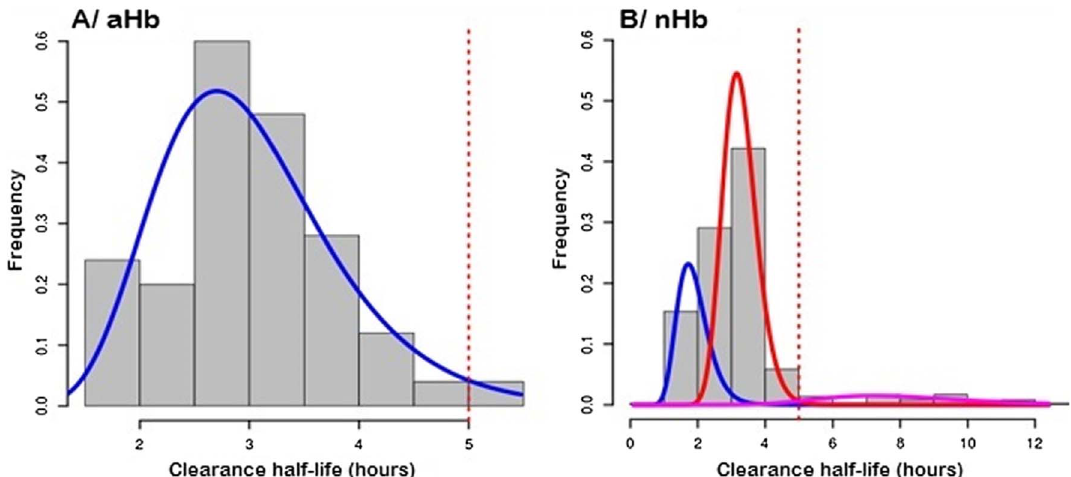
Figure 2. Modeling the population parasite number according to the hemoglobin type. The parasite half-life time is plotted for those with (A) or without (B) abnormal hemoglobin according to the White et al. [27] , distribution model. For aHb, the model describes only one phenotype (half-life time = 2.15 ± 1.37 h), whereas for nHb, three phenotypes were found: i) phenotype 1 (blue line, half-life time = 1.83 ± 1.28 h) accounting for 25.4% of the patients, ii) phenotype 2 (red line, half-life time = 3.23 ± 1.17 h) accounting for 66.88% of the patients, and iii) phenotype 3 (pink line, half-life time = 7.78 ± 1.32 h) accounting for 7.73%. The red line highlights the threshold of potential resistance (half-life more than > 5 h). aHb (Abnormal hemoglobin), nHb (Normal